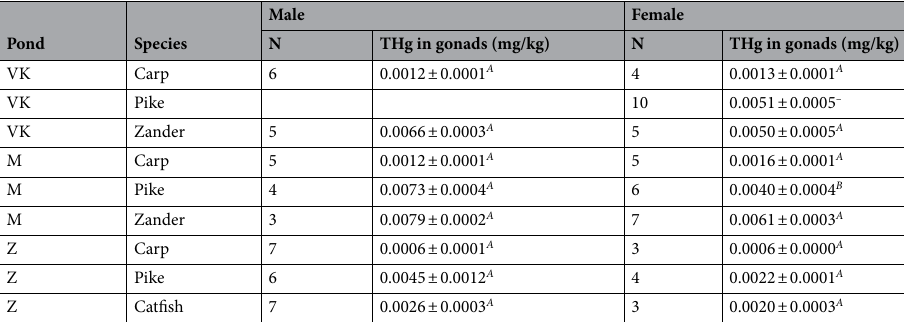
Similarly, in zander the mercury content in muscle did not differ (P > 0.05) between Velky Kocelovicky (0.0452 ± 0.0035 mg/kg) and Mysliv (0.0647 ± 0.0030 mg/kg). The situation was different for pike, where the mercury content in the muscle ranged from 0.0398 ± 0.0108 mg/kg in Zehunsky to 0.1517 ± 0.0176 mg/kg in Velky Kocelovicky and differed significantly (P < 0.05) (Table 2). The mercury content in the liver of fish ranged from 0.0016 ± 0.0002 mg/kg (carp, Zehunsky pond) to 0.0402 ± 0.0046 mg/kg (pike, Velky Kocelovicky) and did not differ significantly either between species or sam- pling sites (Table 2). In scales, the lowest mercury content was 0.0007 ± 0.0001 mg/kg (carp, Zehunsky) and the highest 0.0042 ± 0.0002 mg/kg (zander, Mysliv). The mercury content in scales did not differ significantly either between fish species or sampling sites (Table 2). The mercury content in the gonads ranged from 0.0006 ± 0.0000 mg/kg (carp, Zehunsky pond) to 0.0067 ± 0.0003 mg/kg (zander, Mysliv) and did not differ significantly either between species or sampling sites (Table 2). A detailed analysis of the mercury content in the gonads of male and female fish found values from 0.0006 ± 0.0001 mg/kg and 0.0006 ± 0.0000 mg/kg, respectively (male and female, carp, Zehunsky pond) to 0.0079 ± 0.0002 (male, zander, Mysliv) (Table 3, Fig. 3). Factorial ANOVA used to identify differences in mercury content in gonads between males and females and taking into account sampling site and fish species did not find significant differences between males and females (effect of gender in factorial ANOVA: F(1,77) = 2.839, P = 0.096). Despite this, the Tuckey post hoc test revealed differences in the mercury content in the gonads of males and females of pike from the Mysliv pond; values were higher in males (Table 3). THg liver/muscle ratios was calculated for fish from individual ponds. Ratio higher than 1 means very con- taminated location. If ratio is lower than 1 it is insignificant contamination. As these values are far below 1, they indicate that the fish we monitored came from uncontaminated sites. The highest THg liver/muscle ratio was calculated for catfish from Mysliv pond (Table 4). Hazard index (HI) was calculated for every fish species from three ponds. The highest hazard index was found for pike from the pond Velky Kocelovicky 0.078 and subsequently for pike from the pond Mysliv 0.067. The lowest HI was found in carp 0.002 from pond Zehunsky (Table 4).